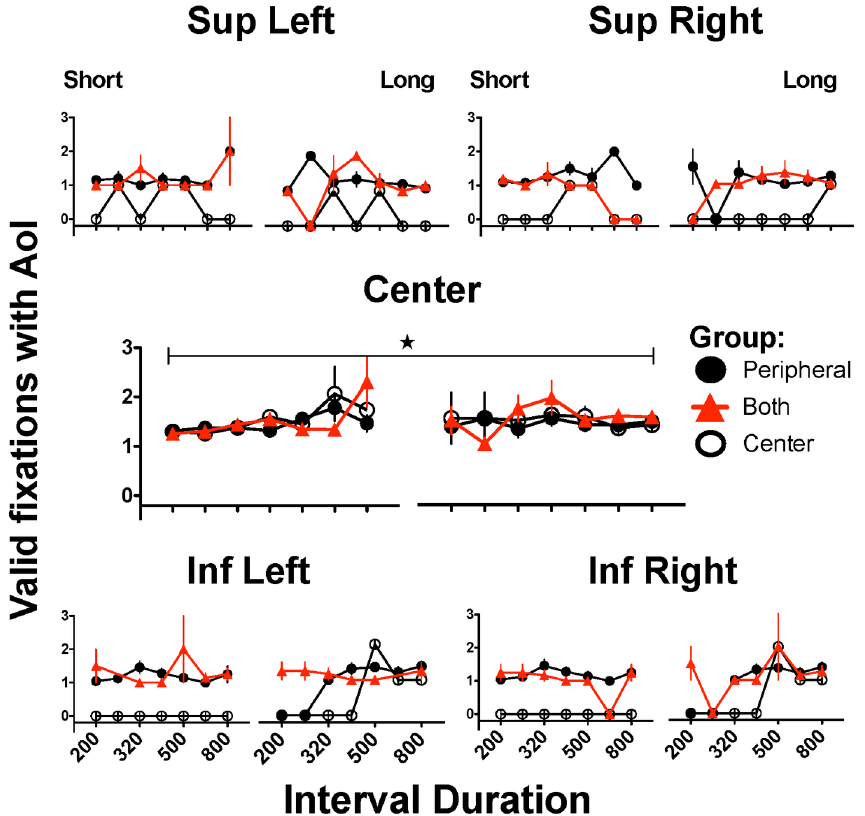
Fig 5. Valid fixations to each Area of Interest during generalization trials. Valid fixation to each Area of Interest (AoI) where stimulus could appear. For each AoI, left panels present the performance on trials where subjects categorized intervals as “ short ” and right panels correspond to categorizations as “ long ” ; only intervals close to or at the extreme durations present mean of 15 subjects since some subjects never emitted erroneous categorizations. Stars and horizontal bars indicate significant differences between denoted groups after two-way ANOVA followed by Bonferroni´s test (p < 0.05) (see text); only data from anchor intervals with N = 15 were included in statistical